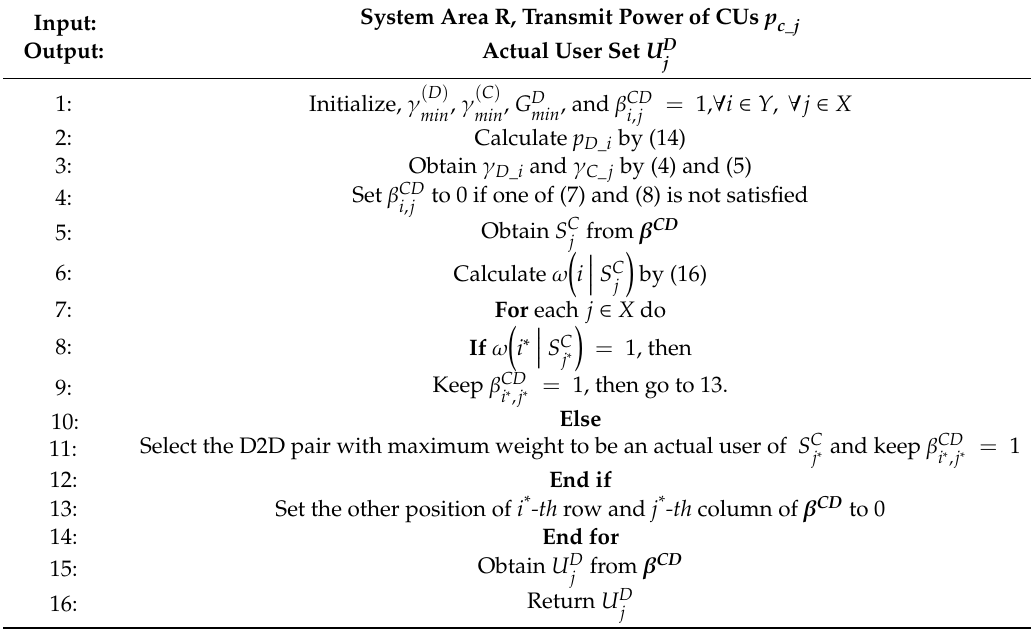
Table 1. Proposed WE-I-A